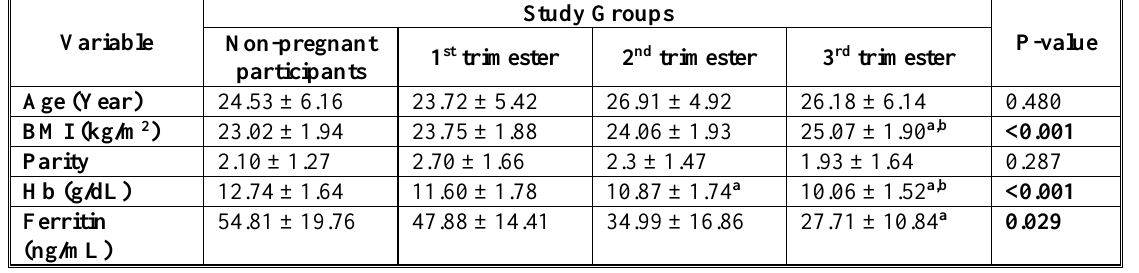
Table 2.Participants’ characteristics by the trimester of pregnancy